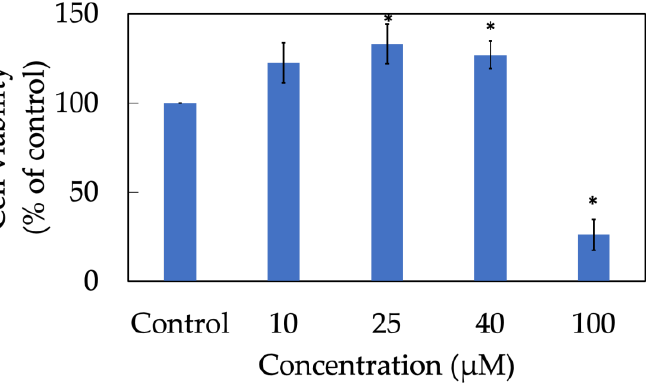
Figure 10. Cell viability of HaCaT keratinocytes treated with liposomal morin formulation 7. Data were presented as mean ± SD and from triplicate experiments. * indicates a statistically significant difference with control group, p < 0.05.